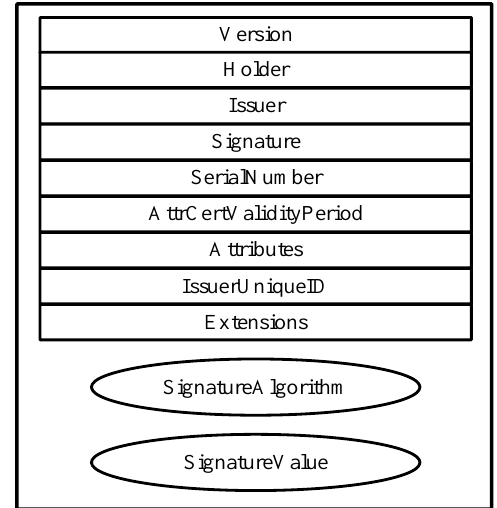
Figure 3. The format of the attribute